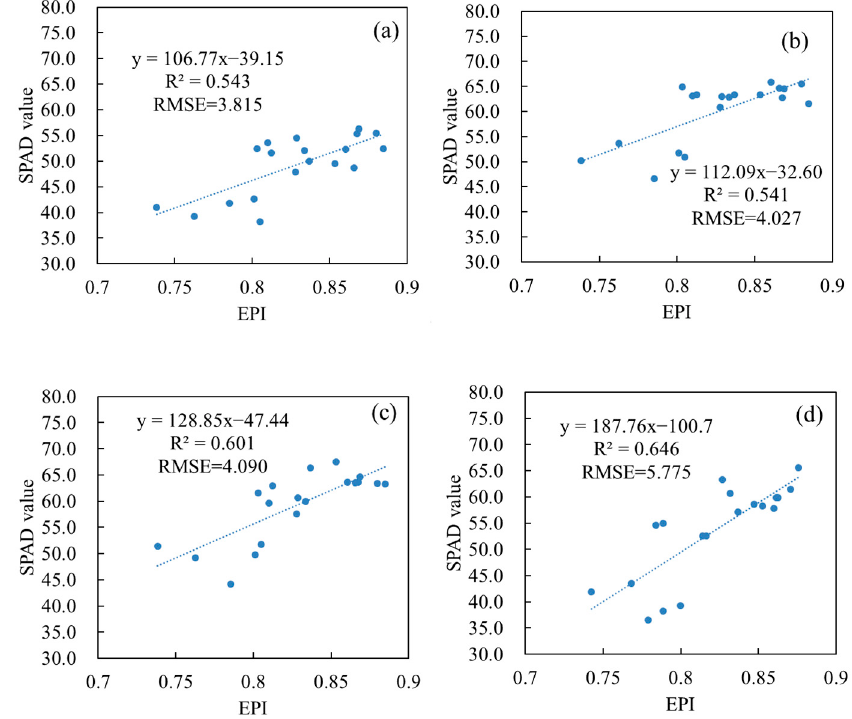
Figure 8. Relationship between SPAD values at different layers and the EPI under the optimum VZA in the late growth stage: ( a ) 1st layer, ( b ) 2nd layer, ( c ) 3rd layer, and ( d ) 4th layer.